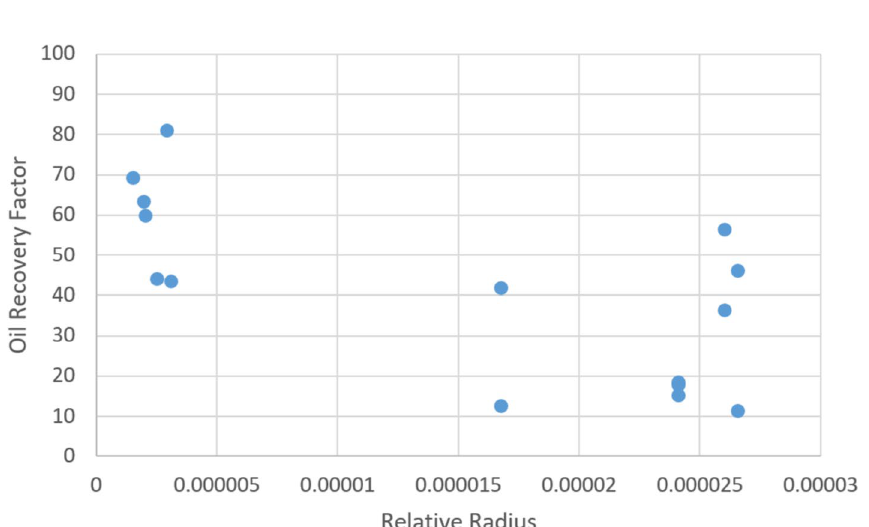
Fig. 2 Relative radius values for low-quality category of porous